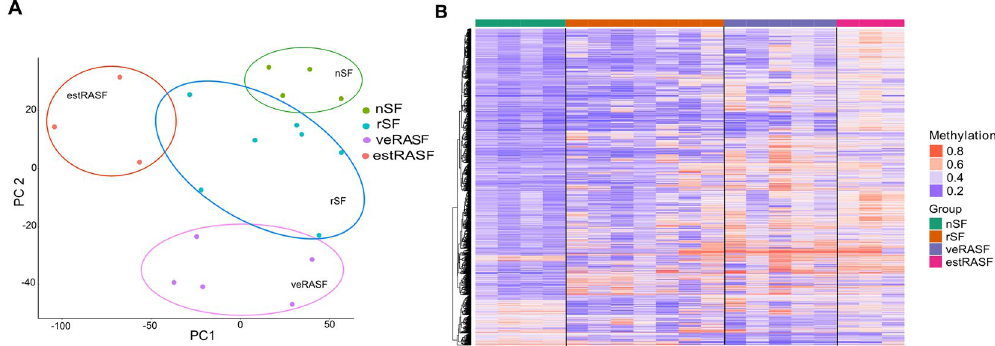
Figure 1. Differentially methylated CpGs at promoter sites (DMPs) differ between diseases and disease stage. DNA methylation at CpGs of promoter regions were compared between SF isolated from healthy individuals (nSF) and patients with resolving, acute arthritis (rSF), very early rheumatoid arthritis (veRA) and patients fulfilling the criteria for the diagnosis of RA (estRA), respectively. ( A) Principal component analysis (PCA) showed a clear separation of SF based on DMPs between the different conditions. ( B) Heatmap of beta values of DMPs across synovial fibroblasts of the different groups. Every row represents the beta value of a DMP CpG and every column is one patient. The colour refers to the level of DNA methylation as shown in the color